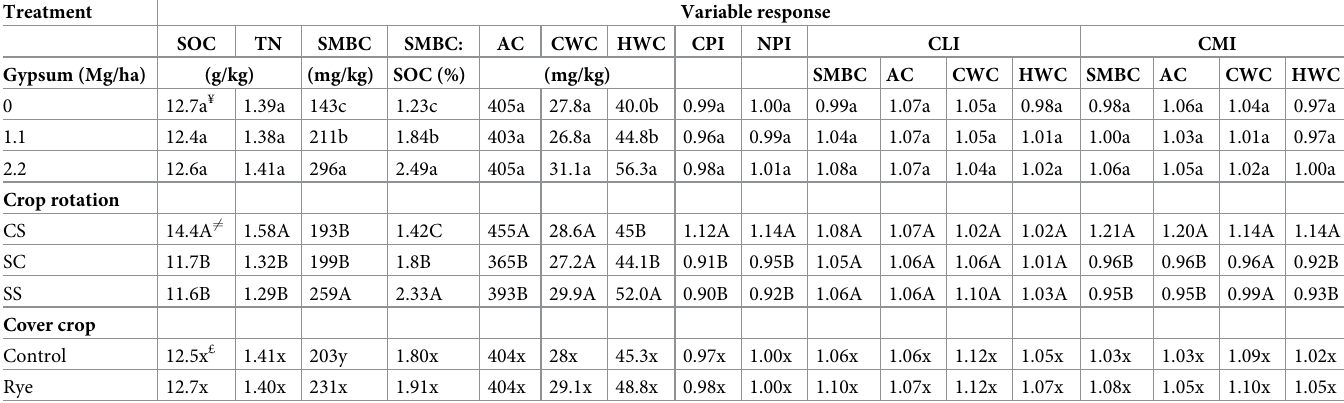
Table 3. Gypsum and cover crop impacts on total soil organic C (SOC), total nitrogen, microbial biomass (SBMC), active carbon (AC), cold (CWC) and hot (HWC) salt water extractable carbon, carbon pool index (CPI), nitrogen pool index (NPI), carbon lability index (CLI) and carbon management index (CMI) under different phases of a rainfed no-till soybean-corn rotation in Indiana (2012 to